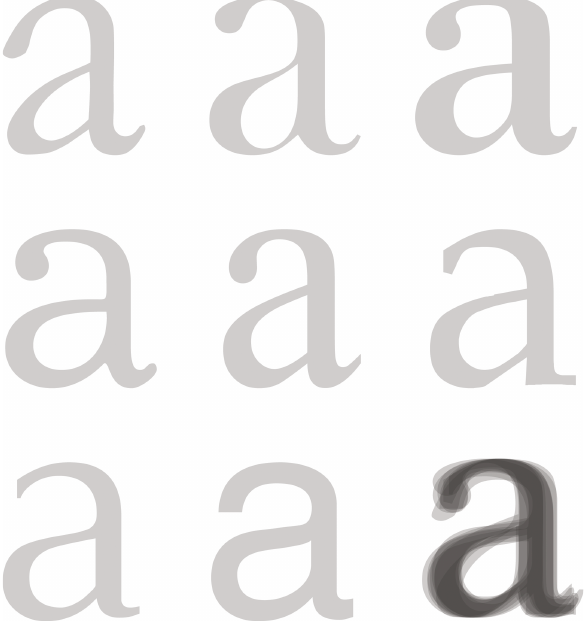
Figure 4. Frutiger’s (1998) Common skeleton,